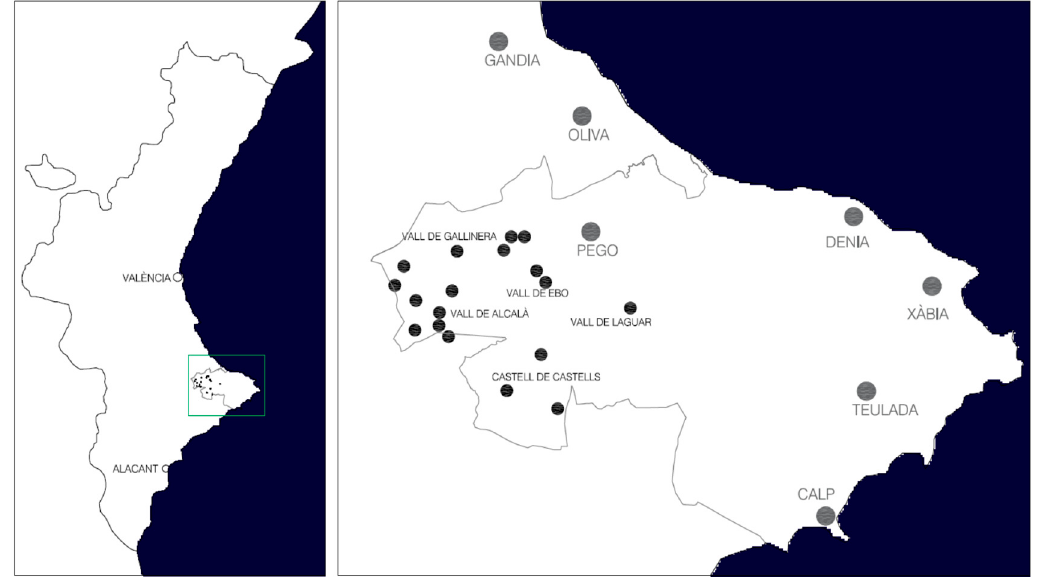
Figure 3. Location map of the survey area. Studied cases: Vall d’Alcalà: Atzuvieta, Benialí, Benixarcos, Cariola, La Roca. Castell de Castells: Aialt, Petracos, Vitla. Vall d’Ebo: Cairola, Serra. Vall de Gallinera: Alcudia, Benimarsoc, Benimoamet, Solana Benissili, Solana Carroja. Vall de Laguar: Isbert.